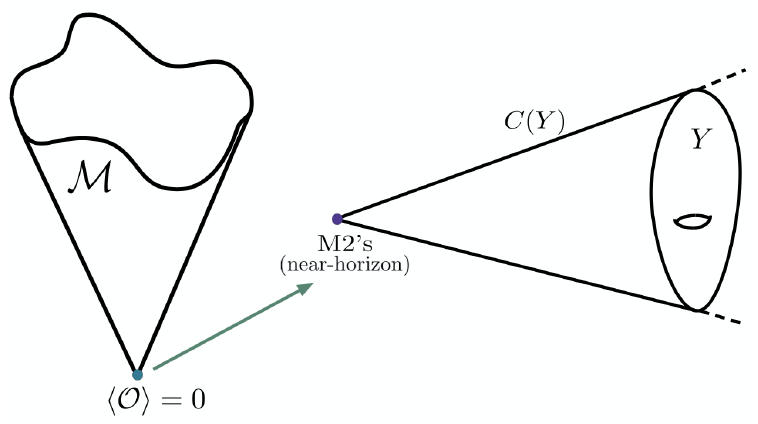
Figure 1 . Superconformal vacuum as origin of the moduli space (on the left) and its dual configuration of M2-branes at the tip of a Calabi-Yau cone, leading to an AdS 4 geometry in the near-horizon